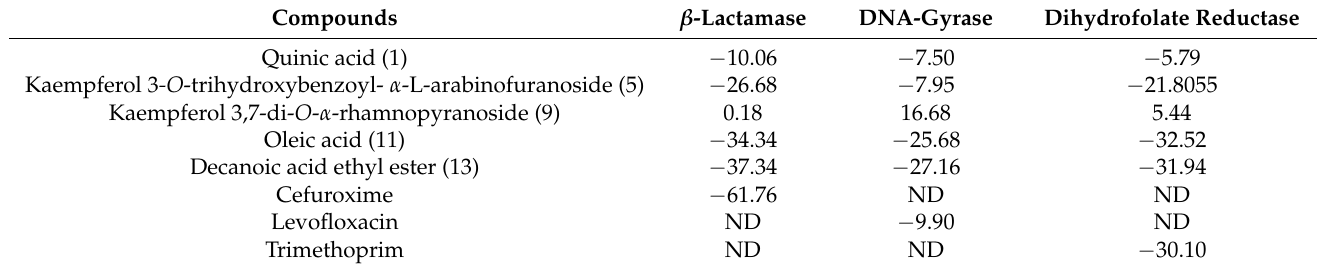
Table 7. Free binding energies ( ∆ G) in Kcal/mol of major compounds identified in L. libyca aerial parts within the active centers of specific enzymes implicated in the incidence of bacterial infections and resistance using molecular